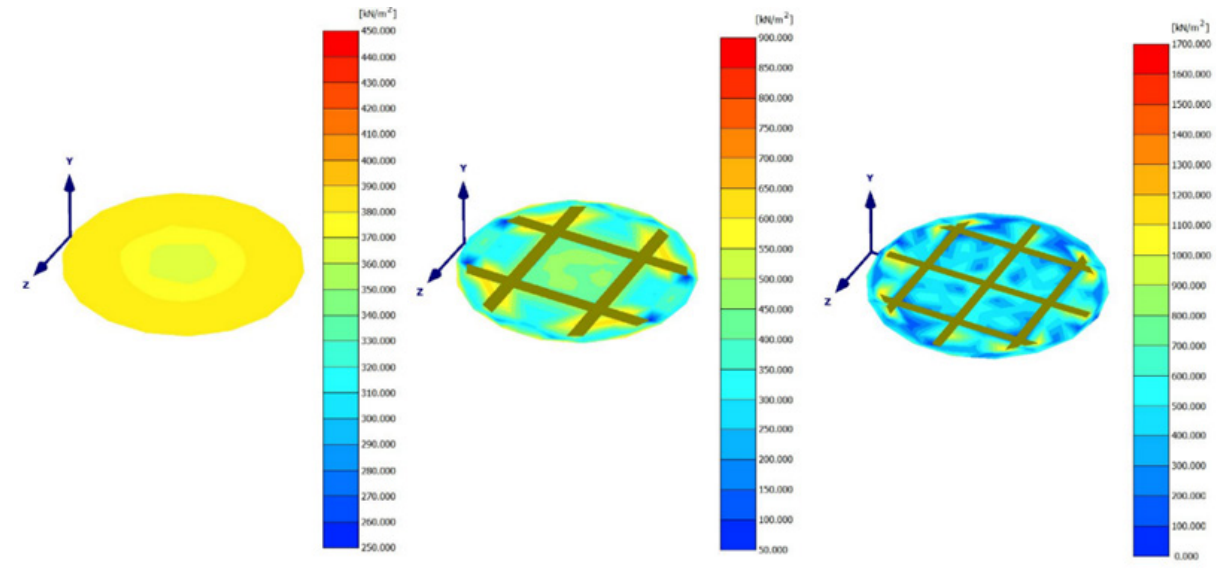
=100 kPa: left – unreinforced 3